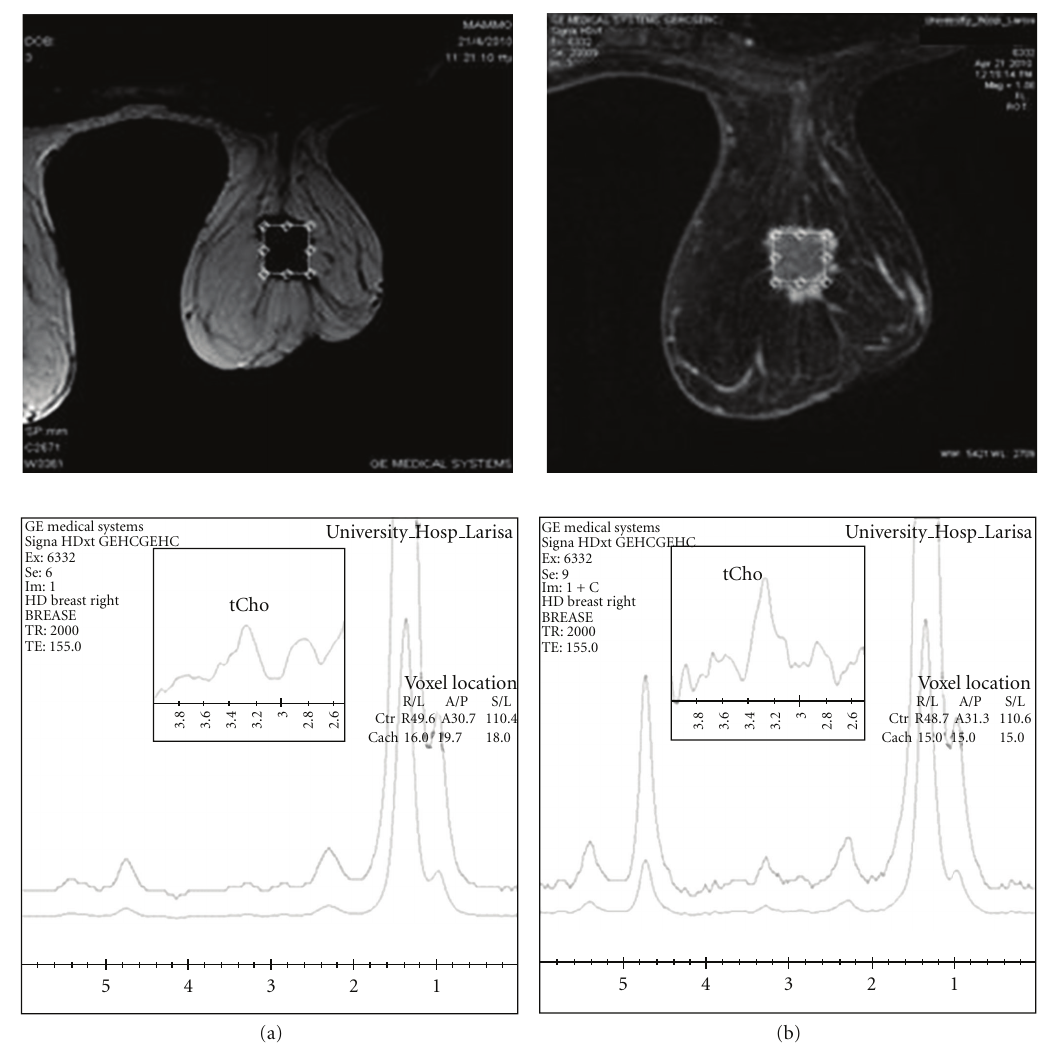
Figure 4: Breast MR spectra of a 63-years old patient with malignant breast lesion, before contrast injection (a) using a voxel of 18 ∗ 19.7 ∗ 18 cm 3 and 8min after (b) contrast injection using a voxel of 15 ∗ 15 ∗ 15 cm 3 which is more adapted to the lesion’s size. After contrast injection the overall spectral resolution is better as FWHM has reduced from 25 Hz to12Hz.